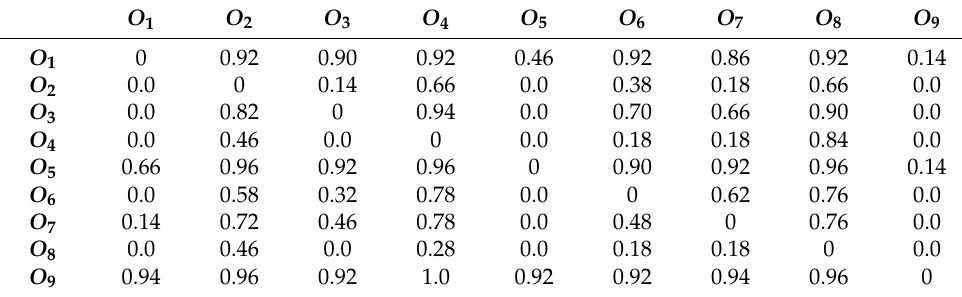
Table 26. Concordance matrix for PLTS ELECTRE II.